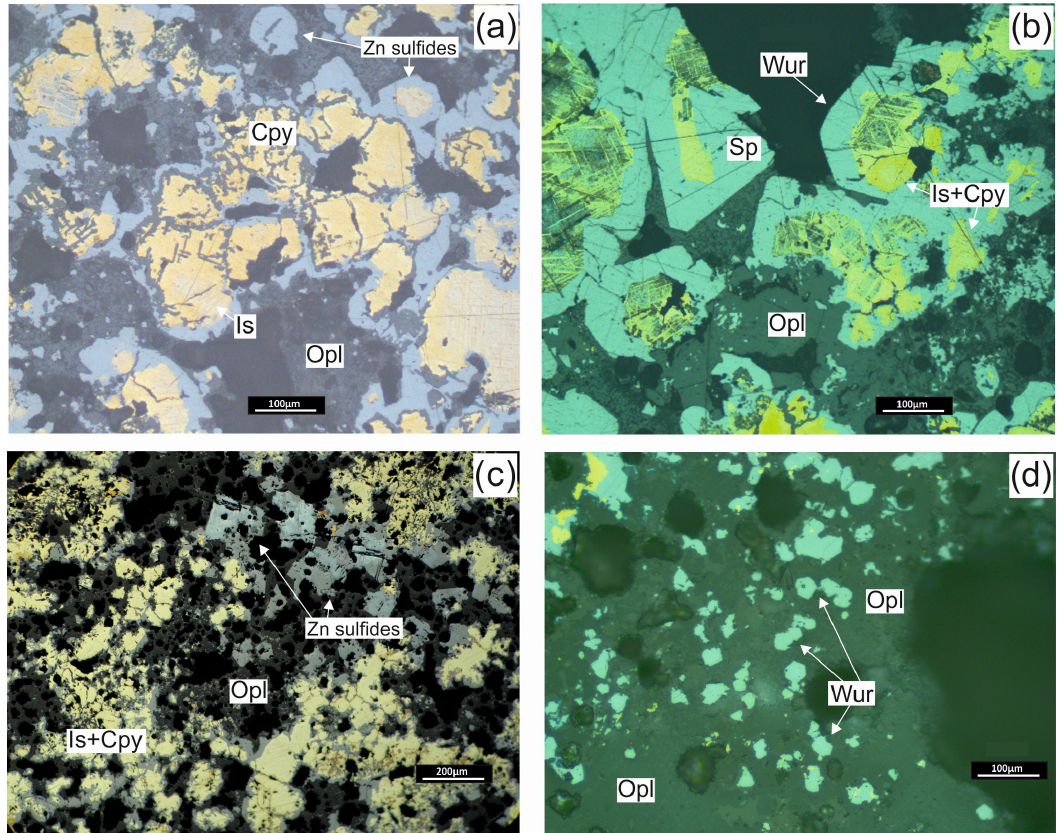
Figure 8. Isocubanite-chalcopyrite-sphalerite-wurtzite-opalmassivesulphides. Reflectedlightphotographs. ( a ) Subsequent formation of isocubanite-chalcopyrite (Is, Cpy) aggregates, Zn-sulphides and then opal (Opl) (287- М- 1 / 2); ( b ) Idiomorphic forms of sphalerite (Sp) and wurtzite (Wur) around small canals (287- М- 1 / 2); ( c )LategenerationofZn-sulphidewitha“patchy”featureofFe-distributionintheircomposition. Zn-sulphide is associated with opal (Opl) infilled small canals and fissures (287- М- 1 / 1); ( d ) Small wurtzite (Wur) crystals in the opal matrix (Opl) (287- М- 1 /